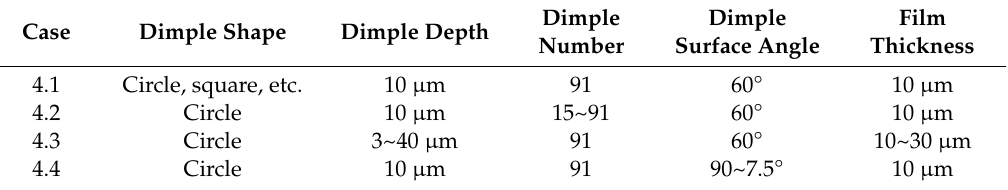
Table 1. Dimple features and film thicknesses for di ff erent simulation cases.